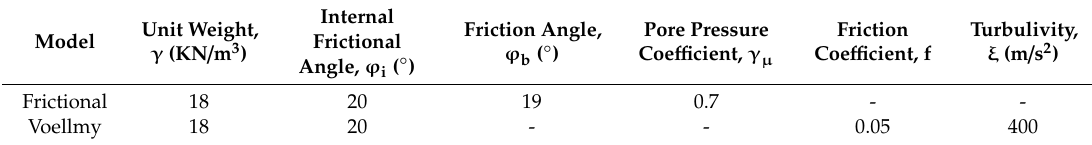
Table 2. Parameters of the Frictional–Voellmy model used for the Panjinbulake landslide.